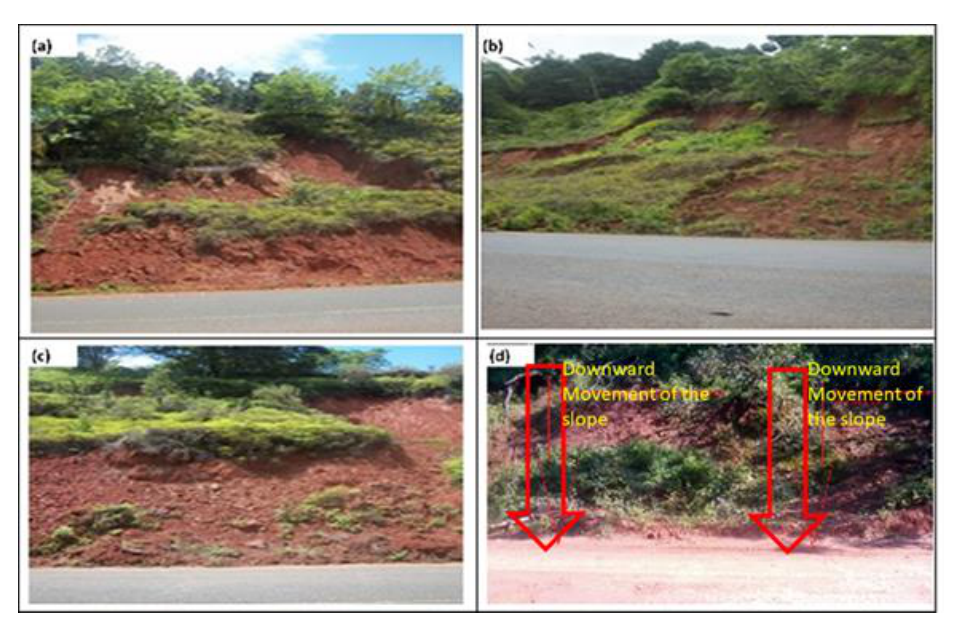
Figure 3. Downward movement of material (soil or rocks) along R523 road, ( a ) occurrences of post landslides along the R523 road; ( b ) Tension cracks observed during the reconnaissance survey; ( c ) evidence of an undercut natural slopes become unstable; ( d ) Block of the slope material sliding toward the road.